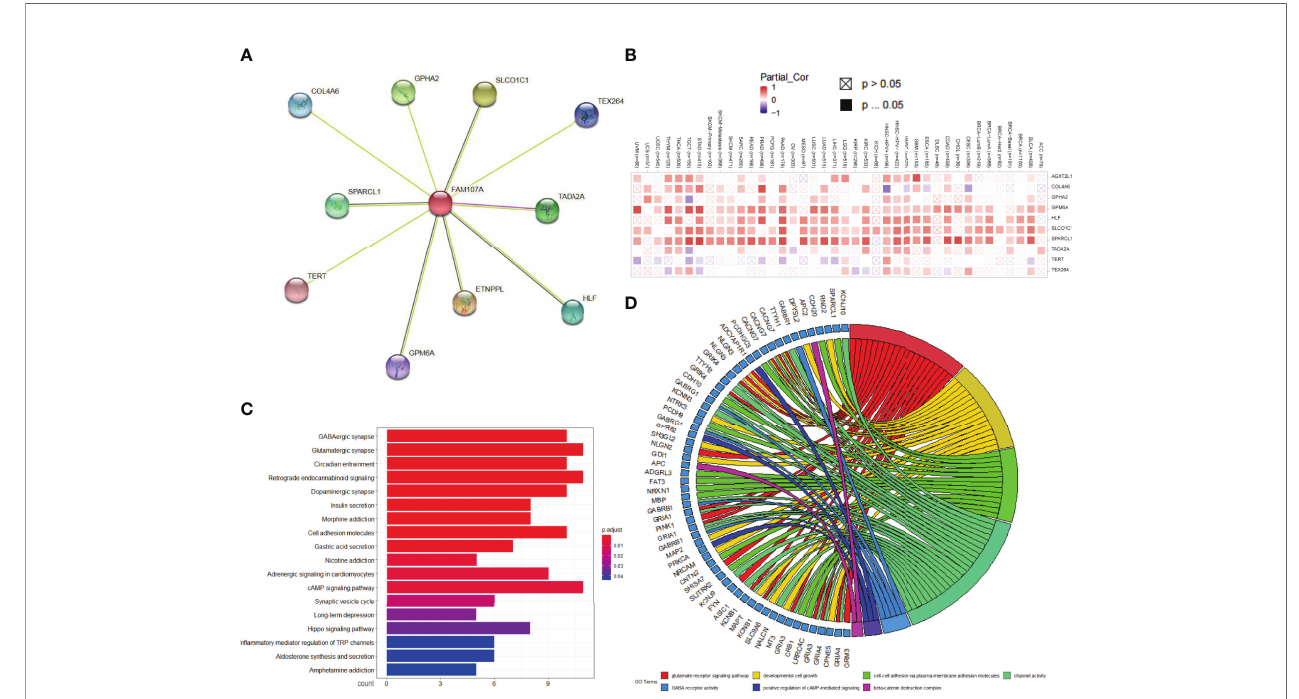
FIGURE 6 | Analysis of FAM107A-related gene enrichment. (A) Available determined FAM107A-binding proteins was obtained with the STRING tool. (B) The heatmap of expression correlation between FAM107A and its binding proteins in the different cancer types are displayed. (C) KEGG pathway analysis was performed based on the FAM107A-binding and correlated genes. (D) The chordal graph for the potential cancer-related terms in GO analysis is